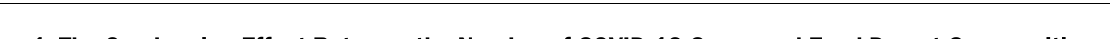
Figure 1. The Overlapping Effect Between the Number of COVID-19 Cases and Food Desert